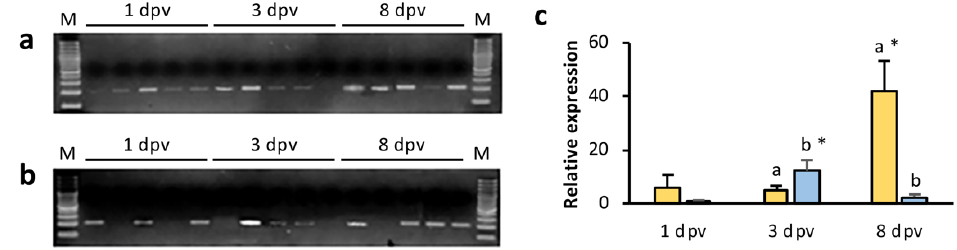
Figure 5. Detection of mcp transcripts in vaccinated gilthead seabream at 1, 3, and 8 days post- vaccination (dpv) in ( a ) head kidney, and ( b ) intestine; M, molecular weight marker (100 bp DNA ladder). ( c ) Relative mcp expression values (2 −ΔΔ Ct ) in positive samples of head kidney (yellow bars) and intestine (blue bars) at different times post-vaccination. The mean value of samples collected at 1 dpv in head kidney or intestine was used as calibrator for mcp expression in the corresponding organ. Data are expressed as mean ± SEM. Different letters denote significant differences between organs at a time point. Significant differences in an organ analyzed at different times post-vaccination are indicated by an asterisk ( p < 0.05).